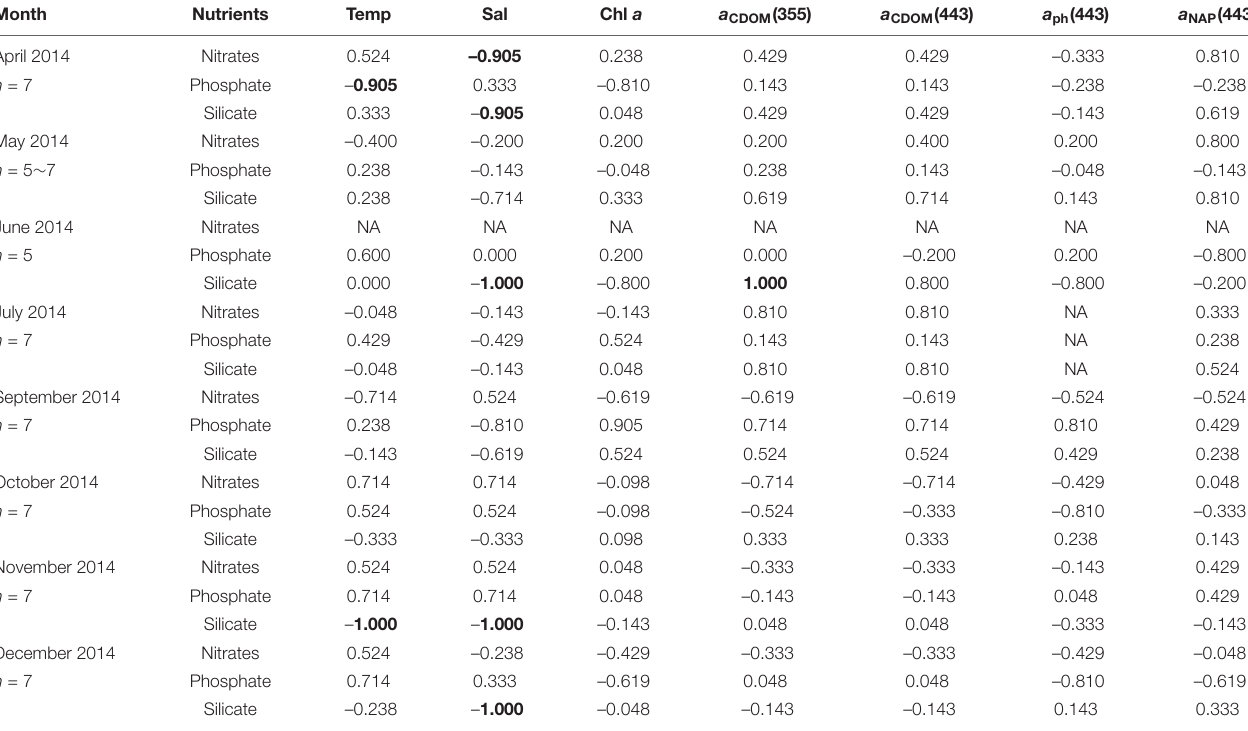
TABLE 3 | Kendall rank correlations coefficient ( τ ) between nutrient concentrations, environmental variables (temperature, salinity, Chl a concentration), and light absorption properties at the surface in AKE during sampling